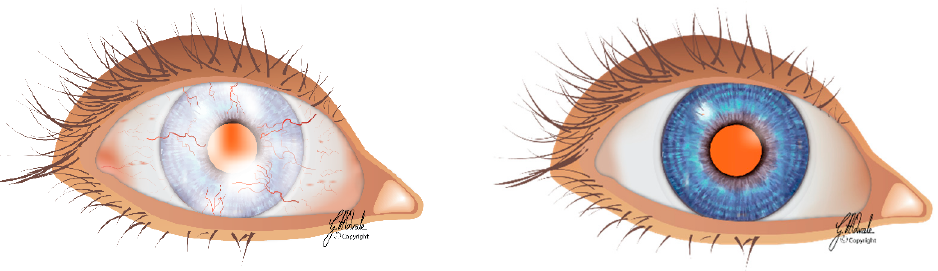
Figure 3. Schematic representation of limbal stem cell-deficient (left) and normal (right) eyes.